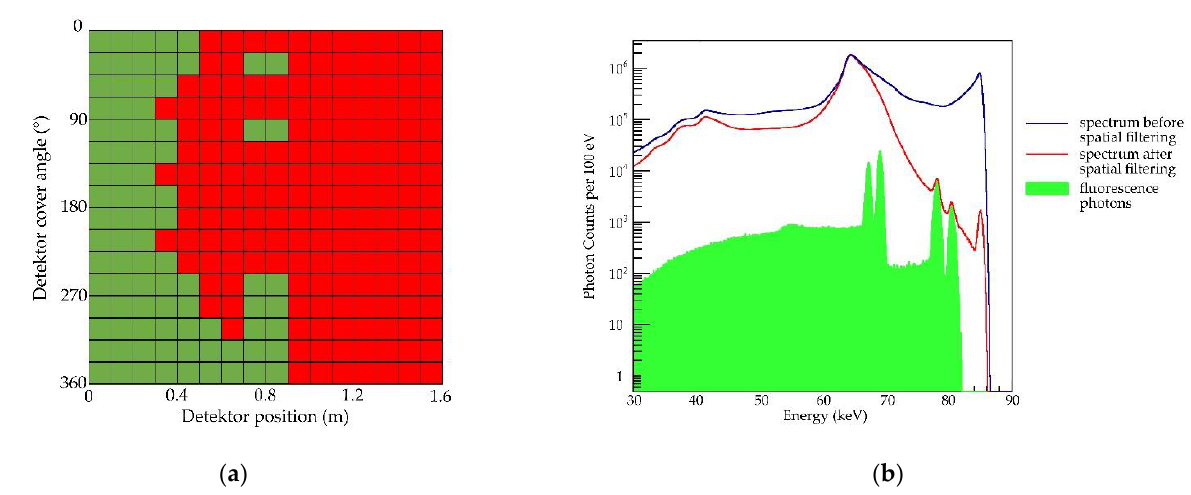
Figure 10. Effects of spatial filtering for K β fluorescence in abdominal prescan for 1.0 mg/mL gold in large intestine: ( a ) Detector panels selected ( green ) and deleted ( red ) for significance calculation after spatial filtering. Cylindrical detector area is spread flat, thus angular position of a tile is plotted against its position over long side of the detector. For K β , mostly backward panels are used for significance calculation because of a smaller background from single Compton scattered photons there; ( b ) corresponding energy spectra before and after filtering. In green, contribution of all fluorescence photons to total spectrum is shown. After spatial filtering, K β peaks are visible, whereas the background in K α region is not decreased enough to make fluorescence photons